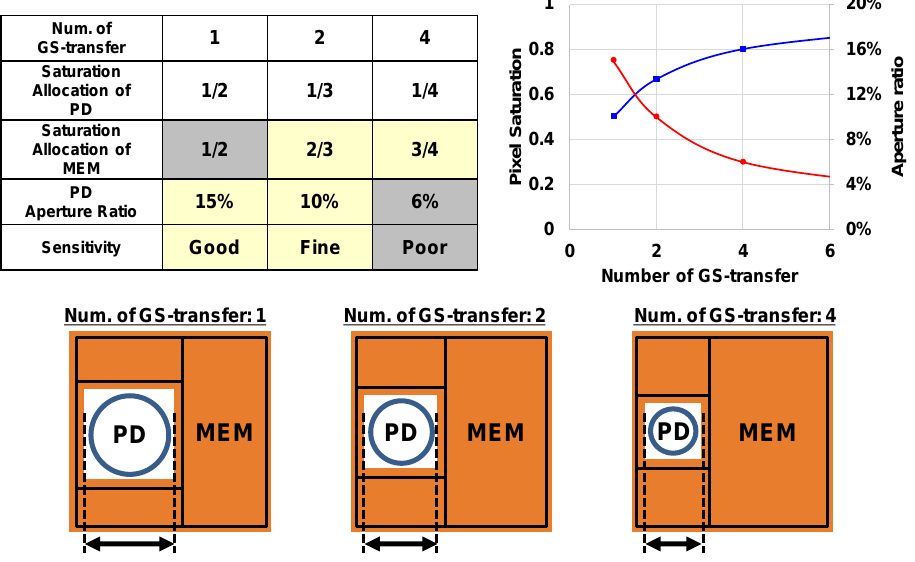
Figure 5. Allocation of saturation and the PD aperture ratio estimated from the layout according to the number of GS-transfer.